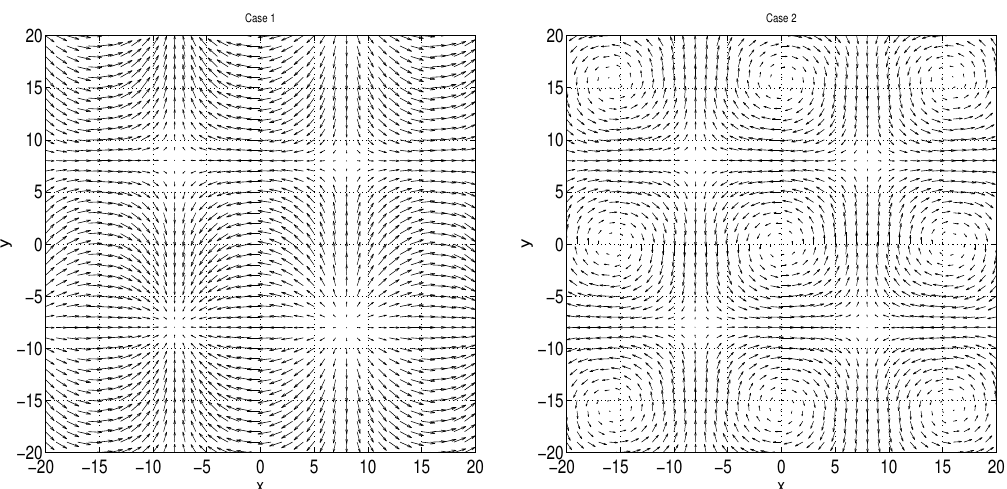
Figure 3. Snapshots of velocity fields for Model 1 ( left ) and Model 2 ( right